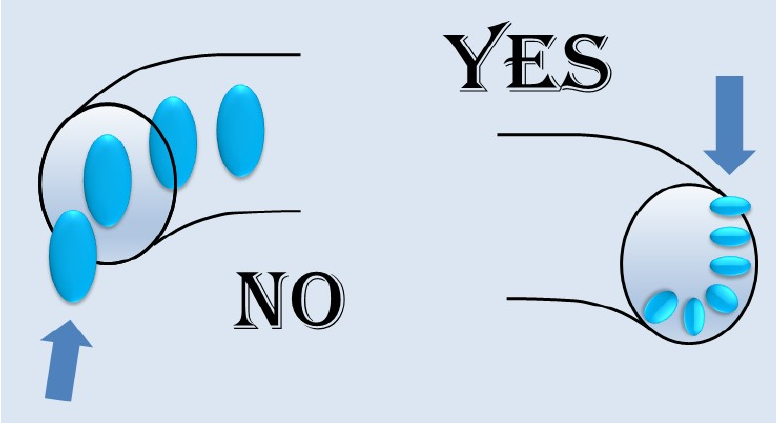
Figure 4. Different ways to send wave-packets in a toroid whispering gallery. According to what suggested in this paper, the signal should not approach the device by staying parallel to the major diameter ( left ), but rather following the orthogonal direction ( right